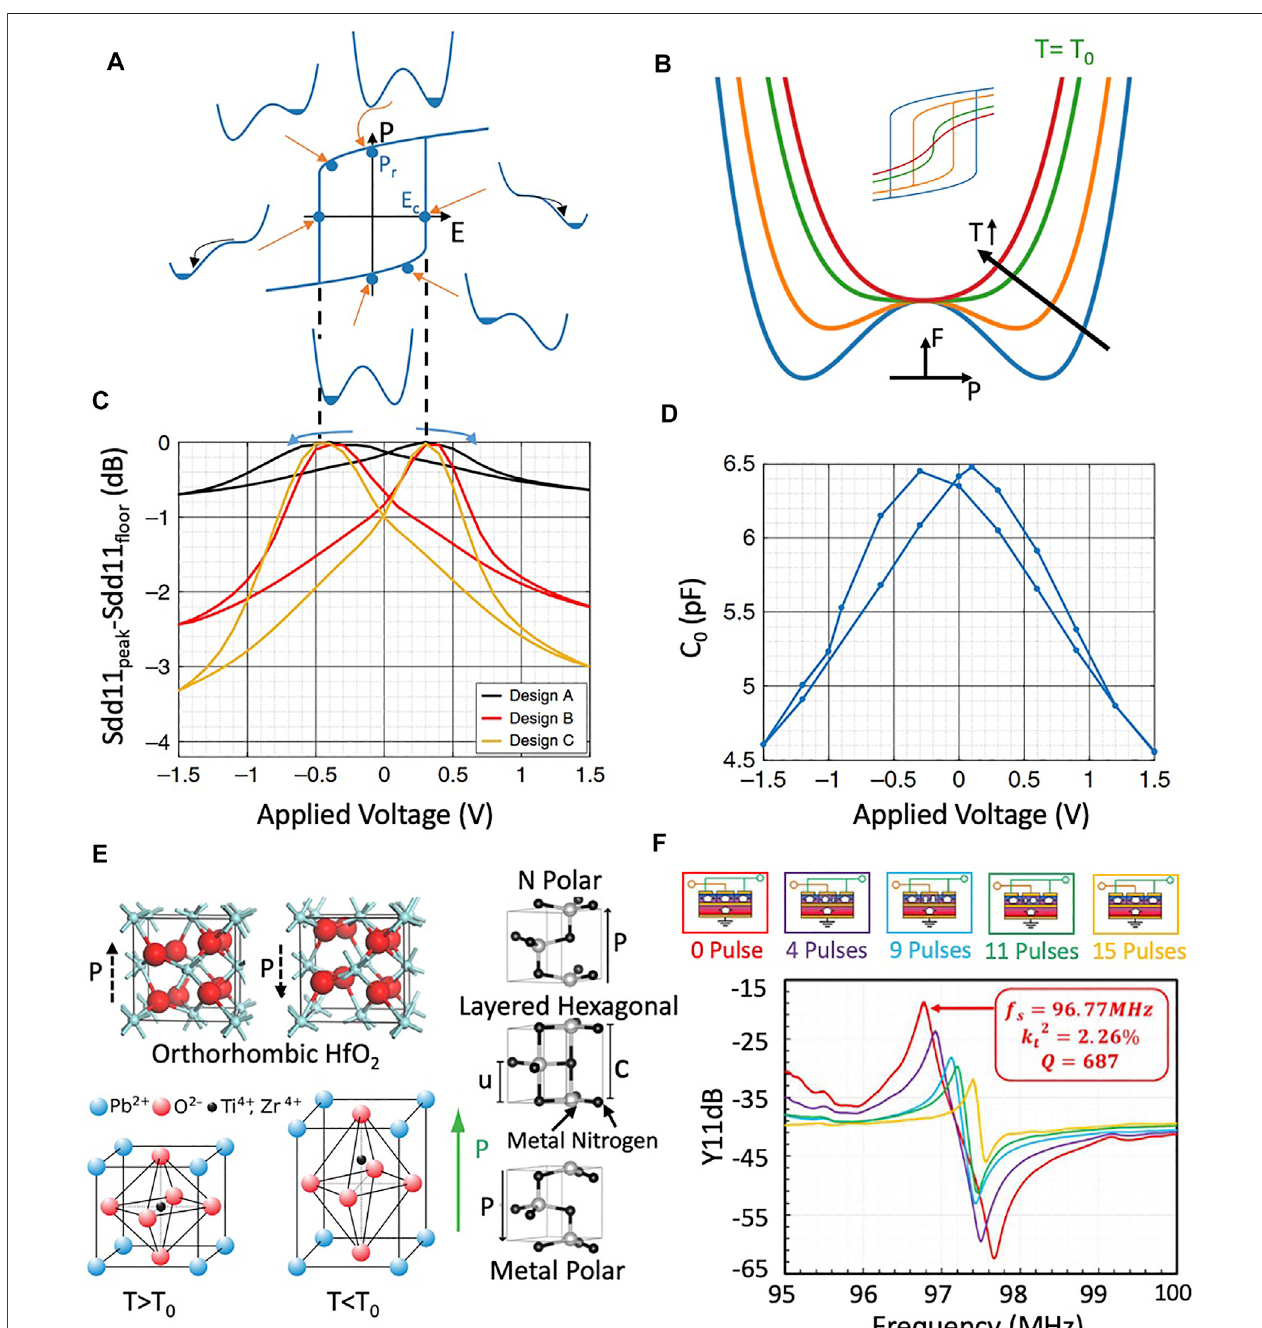
FIGURE7|(A) Ferroelectric fi lmsexhibittwostableenergystatesatnonzeropolarization,modeled via Landautheory(Rabeetal.,2007).Whenapplied fi eldtiltsthe energylandscapeoftheferroelectricdomainsuchthattheoccupiedwelldisappears,thedomainswitchesintotheotherpolarizationstate. (B) Astemperatureincreases, the depth of the wells in the free energy pro fi le decrease (decreasing coercive fi eld) until they disappear altogether at the Curie temperature (shown in green). Above this temperature (red curve), hysteresis disappears and the stable energy minimum occurs at zero polarization, as shown by the inset. The differential curvature of this pro fi le,proportionaltotheinverseofcapacitance,approacheszeroattheCurietemperature,leadingtoalargeincreaseineffectivedielectricconstantnearzero fi eld. (C) The programmability of ferroelectric hysteresis for tunable transduction has been experimentally demonstrated in CMOS (He et al., 2019) with parallel resonance in Sdd11 trending to zero at the coercive voltage as shown in (A) Designs A-C all share a unit cell design, but highlight some of the techniques that can be used to reduce scattering and boost quality factor in unreleased resonators. Designs B and C employing lateral terminating blocks as discussed in Section 3.3 to extend the